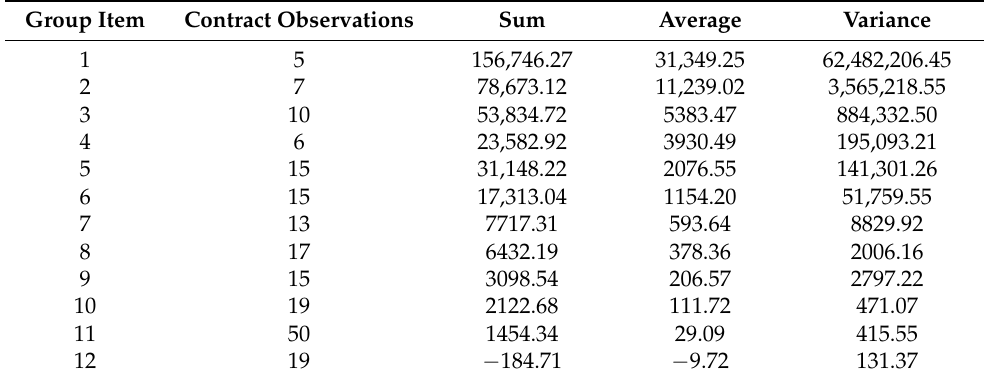
Table 4. Transaction costs